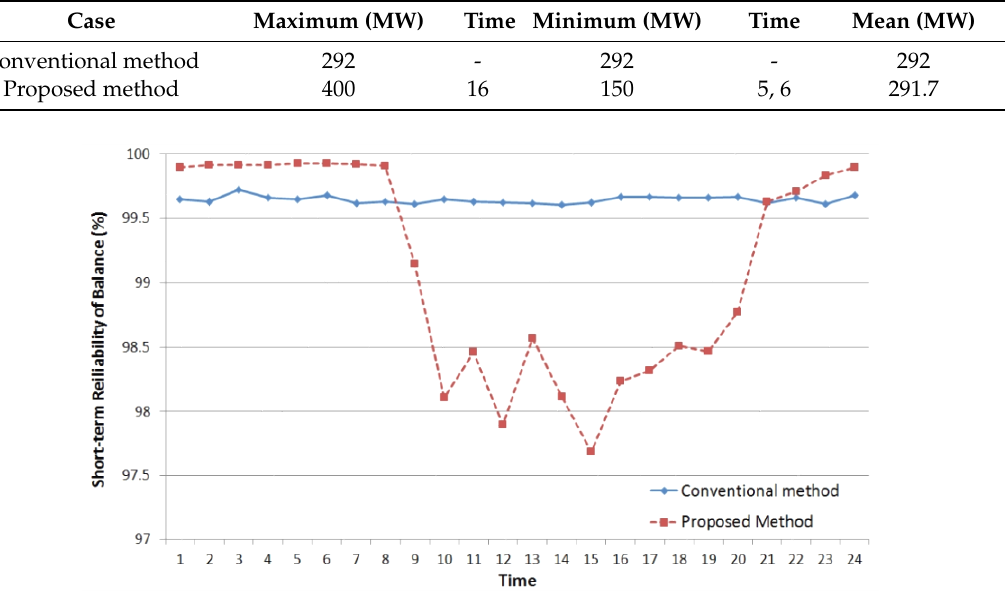
Table 3. Maximum, minimum, and mean reserve margins.